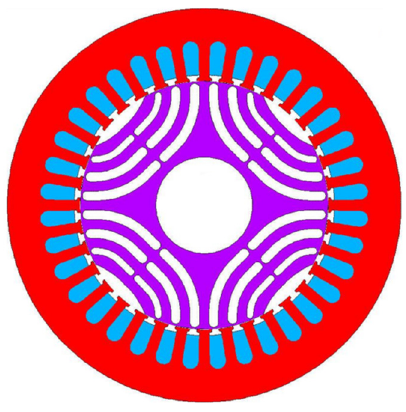
Figure 1. The internal structure of the 2 kW SynRM prototype. Table 1. Parameters of the synchronous reluctance motor (SynRM).